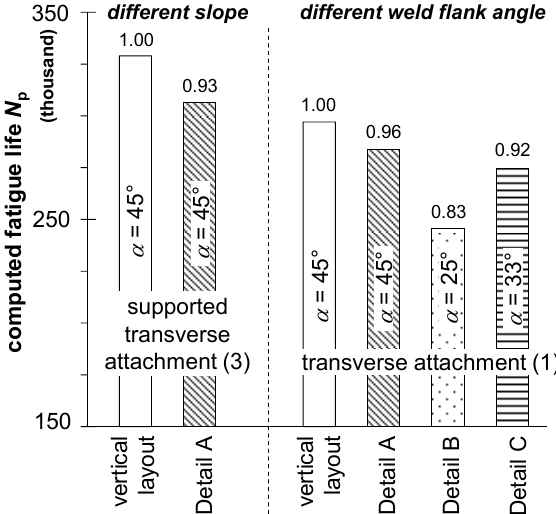
Figure 8: Influence of the layout of the transverse attachment on the SIF.